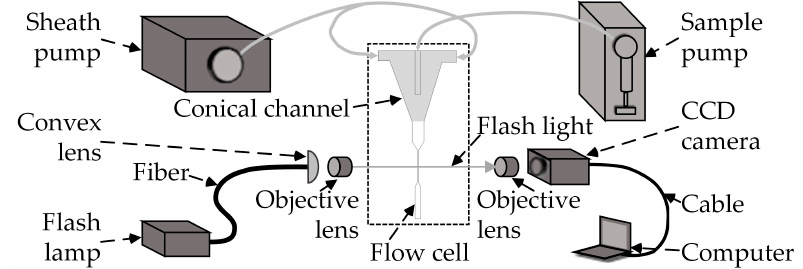
Figure 1. Schematic diagram of the configuration of the microscopic imaging system.